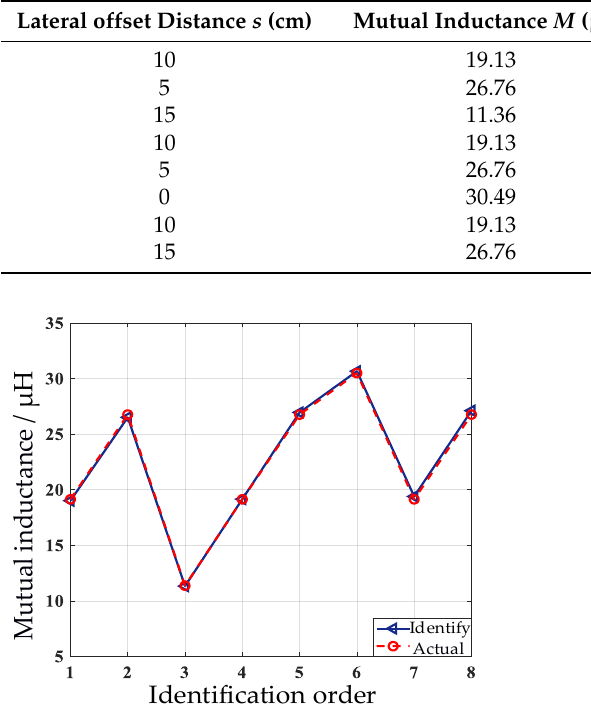
Figure 7. Identification results of R L under different M.